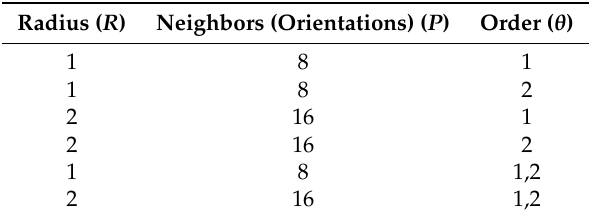
Table 3. Each row describes the parameters used to compute different CLOSIBs and H-CLOSIBs in the experiments. In column “order”, values 1 and 2 indicate that we obtained CLOSIB as a concatenation of the CLOSIBs for each statistical moment, CLOSIB P , R ,1